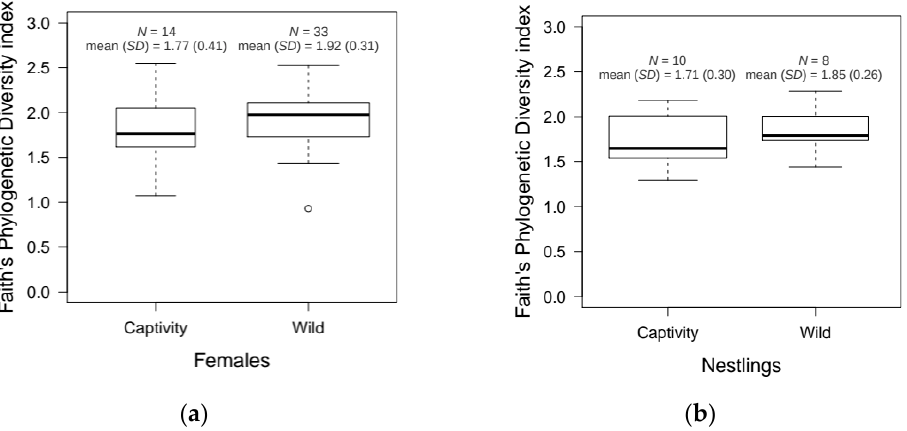
Figure 5. α -Diversity of hoopoes uropygial microbiota in wild and captivity populations. The box plots show the Faith’s phylogenetic diversity index for wild and captive breeding females ( a ), and wild and captive nestlings ( b ).